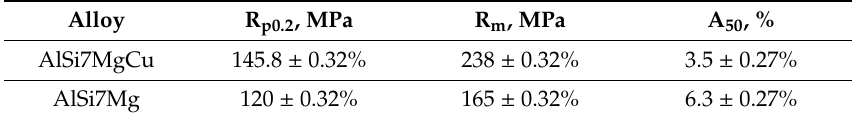
Table 6. Tensile mechanical properties of AlSi7MgCu and commercial AlSi7Mg alloy in as-cast state.